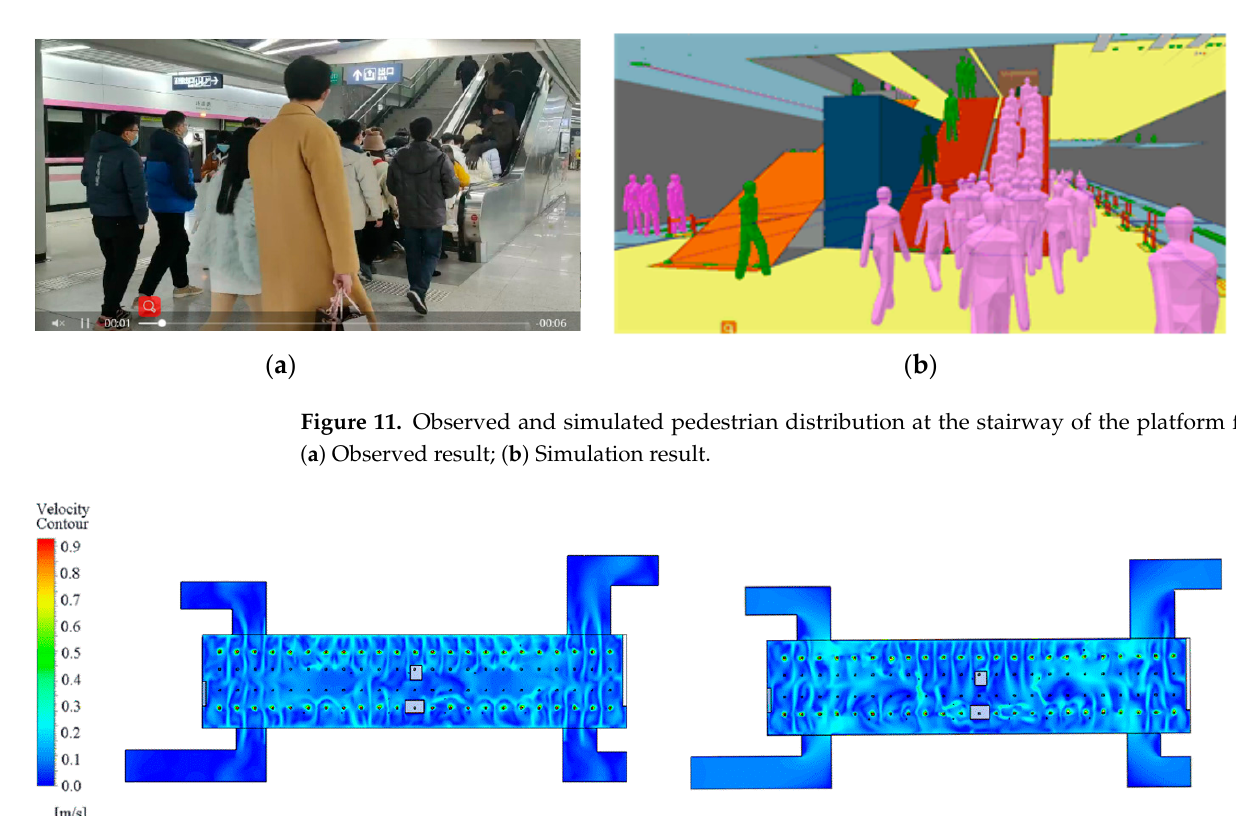
Figure 11. Observed and simulated pedestrian distribution at the stairway of the platform floor: ( a ) Observed result; ( b ) Simulation result.